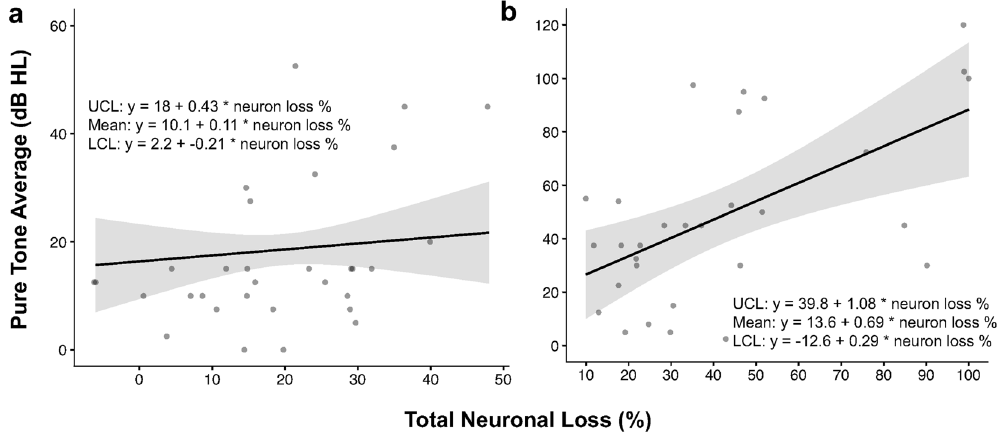
Figure 6. Relationship between pure tone average (dB HL) and total neuronal loss (% of age-based mean) in severe neural degeneration. ( a ) Normal presbycusis (n = 33 ears, published in Makary et al ., 2011); ( b ) severe neural degeneration (n = 30 ears). In patients with severe neural degeneration, mean hearing thresholds increase by 6.9 dB HL per 10% total neuronal loss. Shaded area, 95% confidence interval; UCL, upper confidence limit; LCL, lower confidence